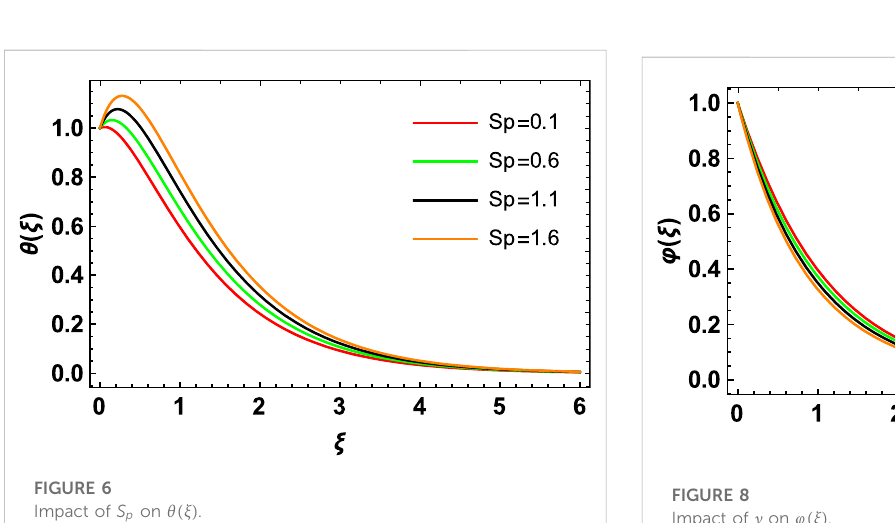
FIGURE 7 Impact of H S on θ ( ξ ) .